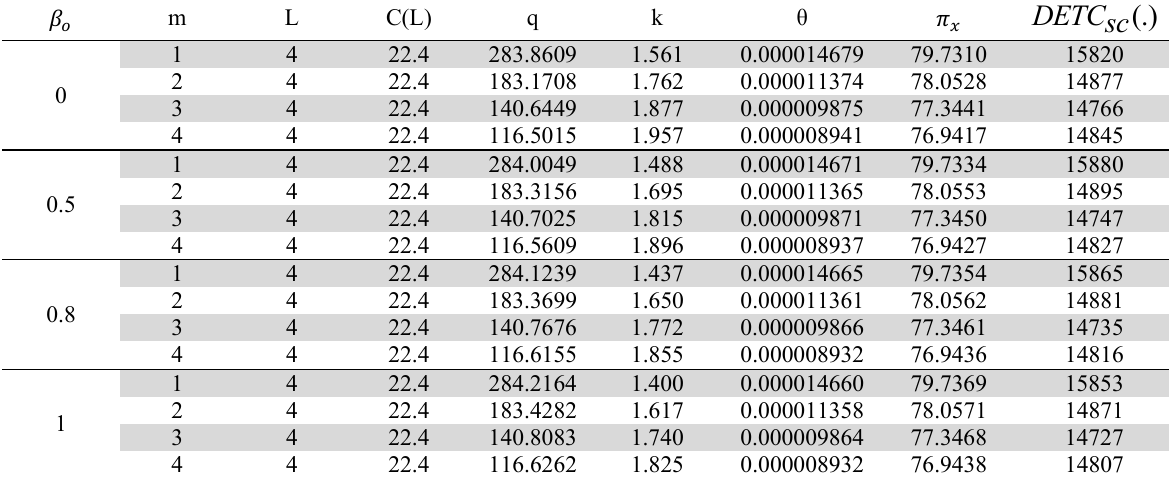
Solution procedures of numerical example (L i in weeks)